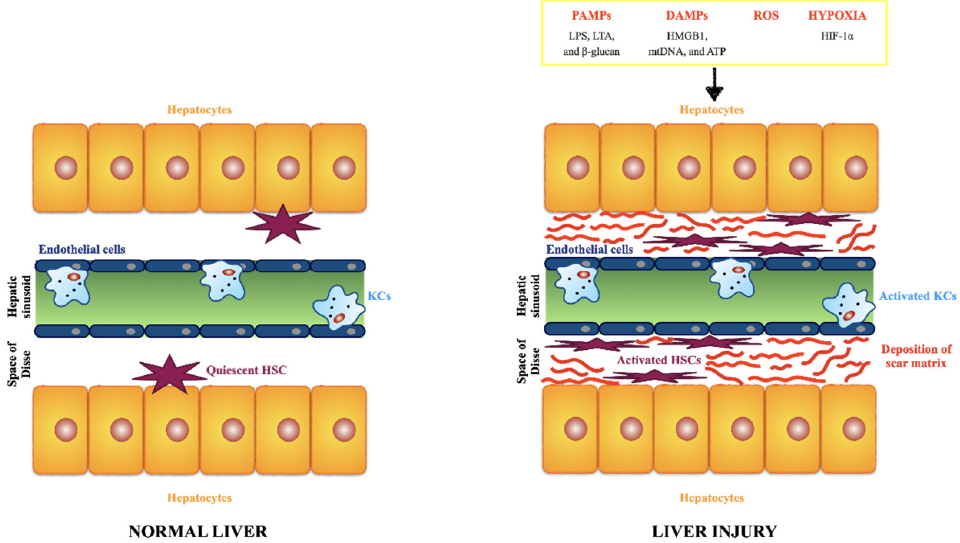
Figure 3. Comparison of matrix and cellular environments in healthy and damaged liver.